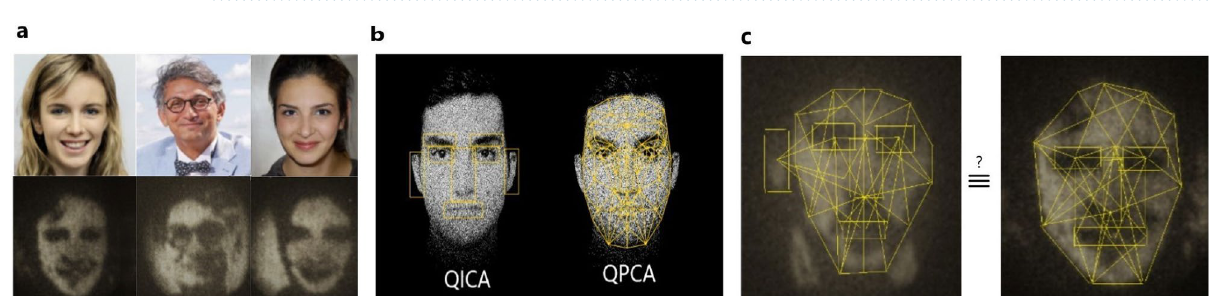
Figure 2. Intelligent pattern recognition in quantum imaging. Data from quantum imaging methods such as ( a ) interaction free imaging and ( b ) ghost imaging act as an input to ( c ) quantum pattern recognition processor (QPRP). The latter, i.e., QPRP, applies quantum machine learning to find the patterns in the database.